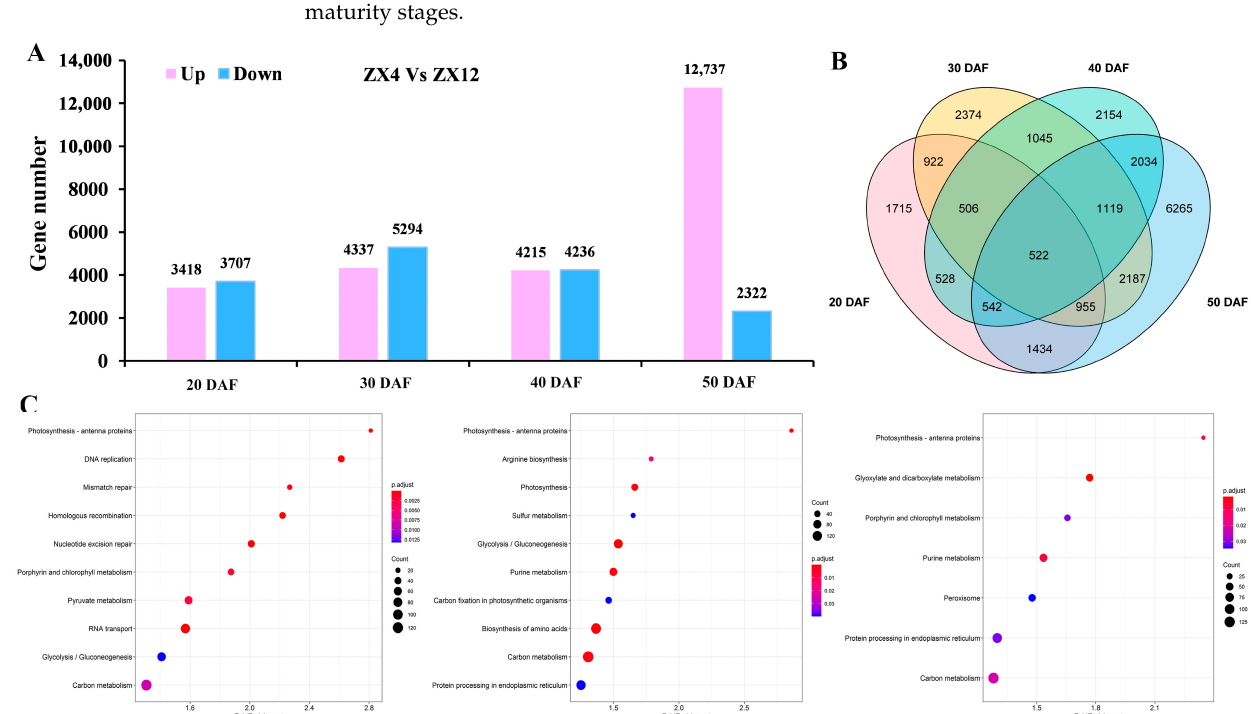
Figure 3. Transcriptome analysis of ZX12 and ZX4 seeds at different maturity stages. ( A ) Number of DEGs in ZX12 and ZX4 seeds at different maturity stages. ( B ) Venn diagram of DEGs between ZX12 and ZX4 seeds at different maturity stages. ( C ) KEGG analysis on the differentially expressed genes at 20, 30, and 40 DAF.